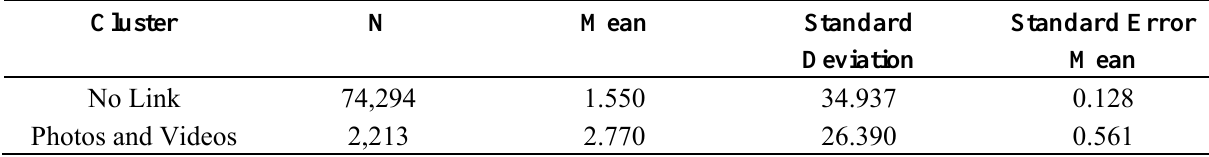
Table 1. Descriptive statistics of our